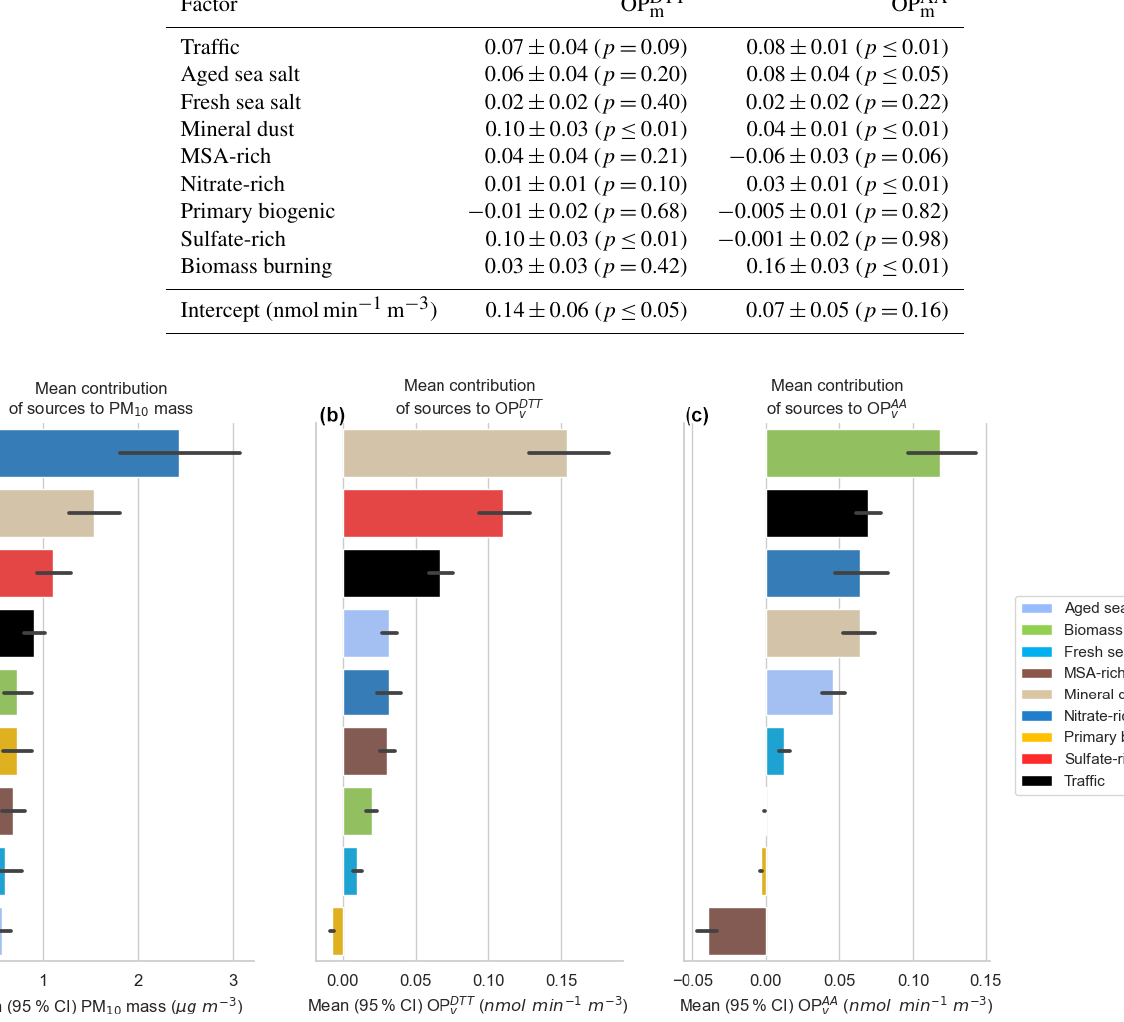
Figure 10. Overall daily mean OP v contribution of the sources to PM 10 and OP activity (OP DTT v and OP AA v ) using MLR analysis in the form of mean and 95% confidence interval of the mean (error bar) ( n = 168